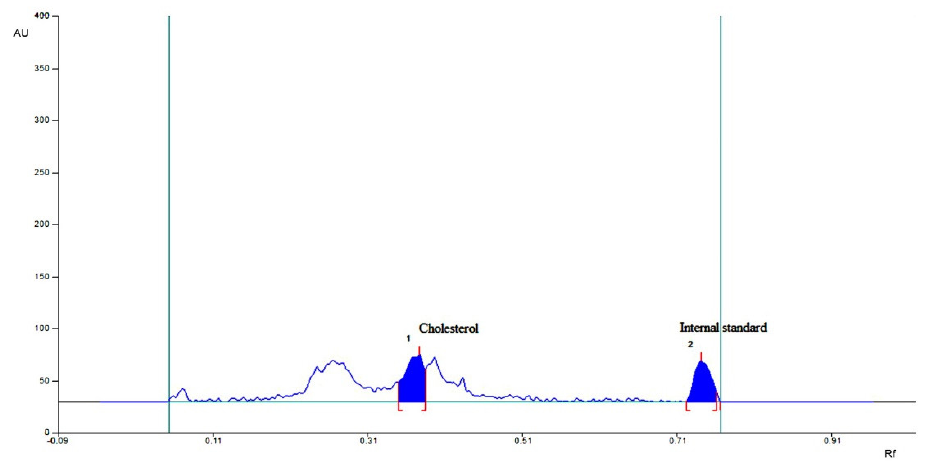
Figure 4. HPTLC analysis of sterols present in feces of CS-SS nanoformulation-treated mice. The concentrations of simvastatin/simvastatin metabolite (18.98 ± 0.20